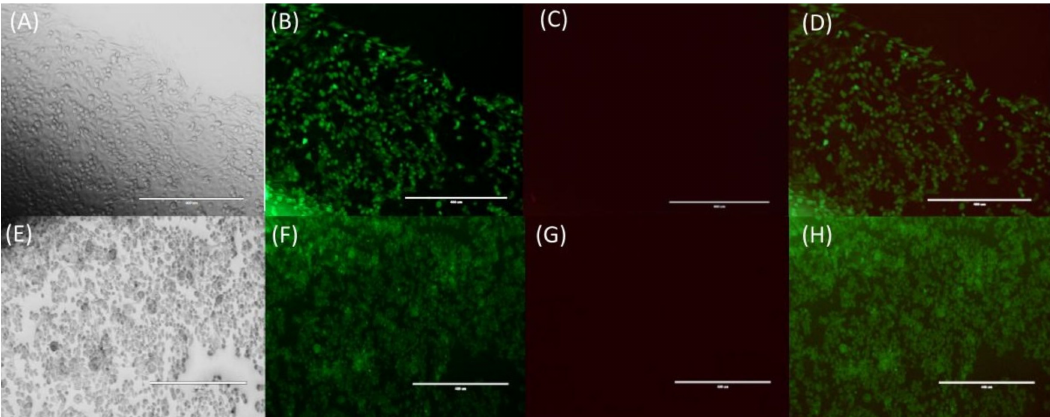
Figure 2. HeLa cells stained with Live/Dead ® kit, scale bar = 400 µ m observed under an EVOS FL microscope, Life Technologies, Carlsbad, CA, USA. The assay shows live cells stained with calcine-AM (green) and dead cells, evidenced by ethidium-1 homodimer (red). ( A – D ) Designate the normal morphology of the untreated cell line. ( E – H ) Represent cells after treatment with 781.25 µ g/mL ETHOSS for 24 h. ( A , E ) Cells observed by a phase-contrast microscope. ( B , F ) Live cells stained with Live/Dead ® kit and observed by fluorescence microscope with fluorescein optical filter, 485 ± 10 nm. ( C , G ) Dead cells stained with Live/Dead ® kit and observed by fluorescence microscope with fluorescein optical filter, 530 ± 12.5 nm. ( D ) Represents the overlap of ( B , C ). ( H ) Represents the overlap of ( F , G ).